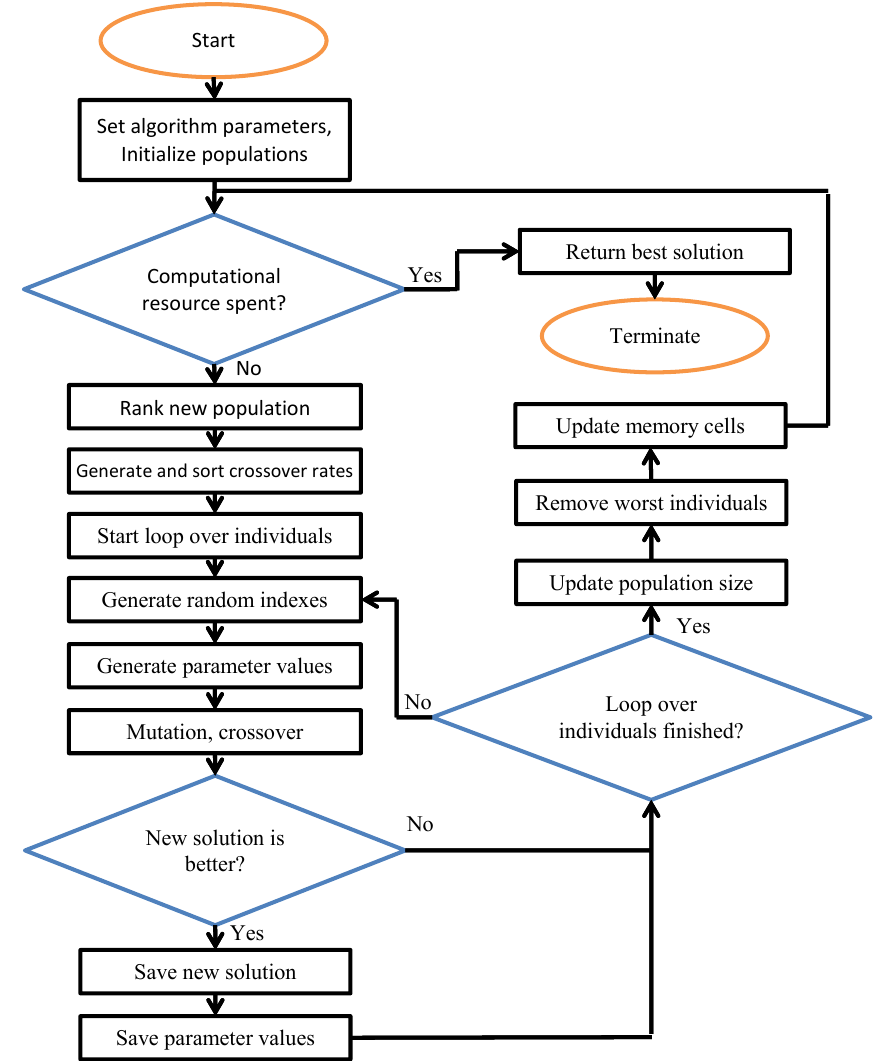
Figure 1. Block-scheme of the L-NTADE_s